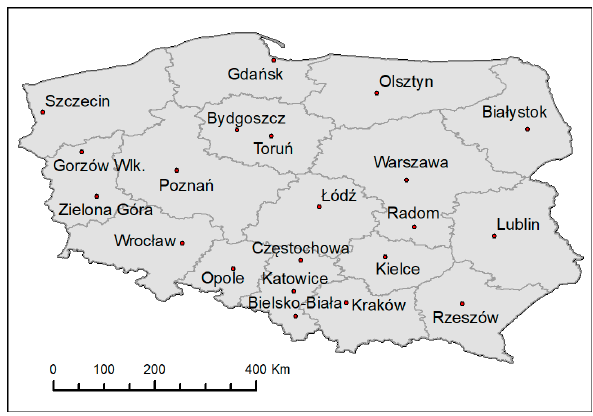
Figure 1. Poland. First level administration units (voivodships) and selected big cities.